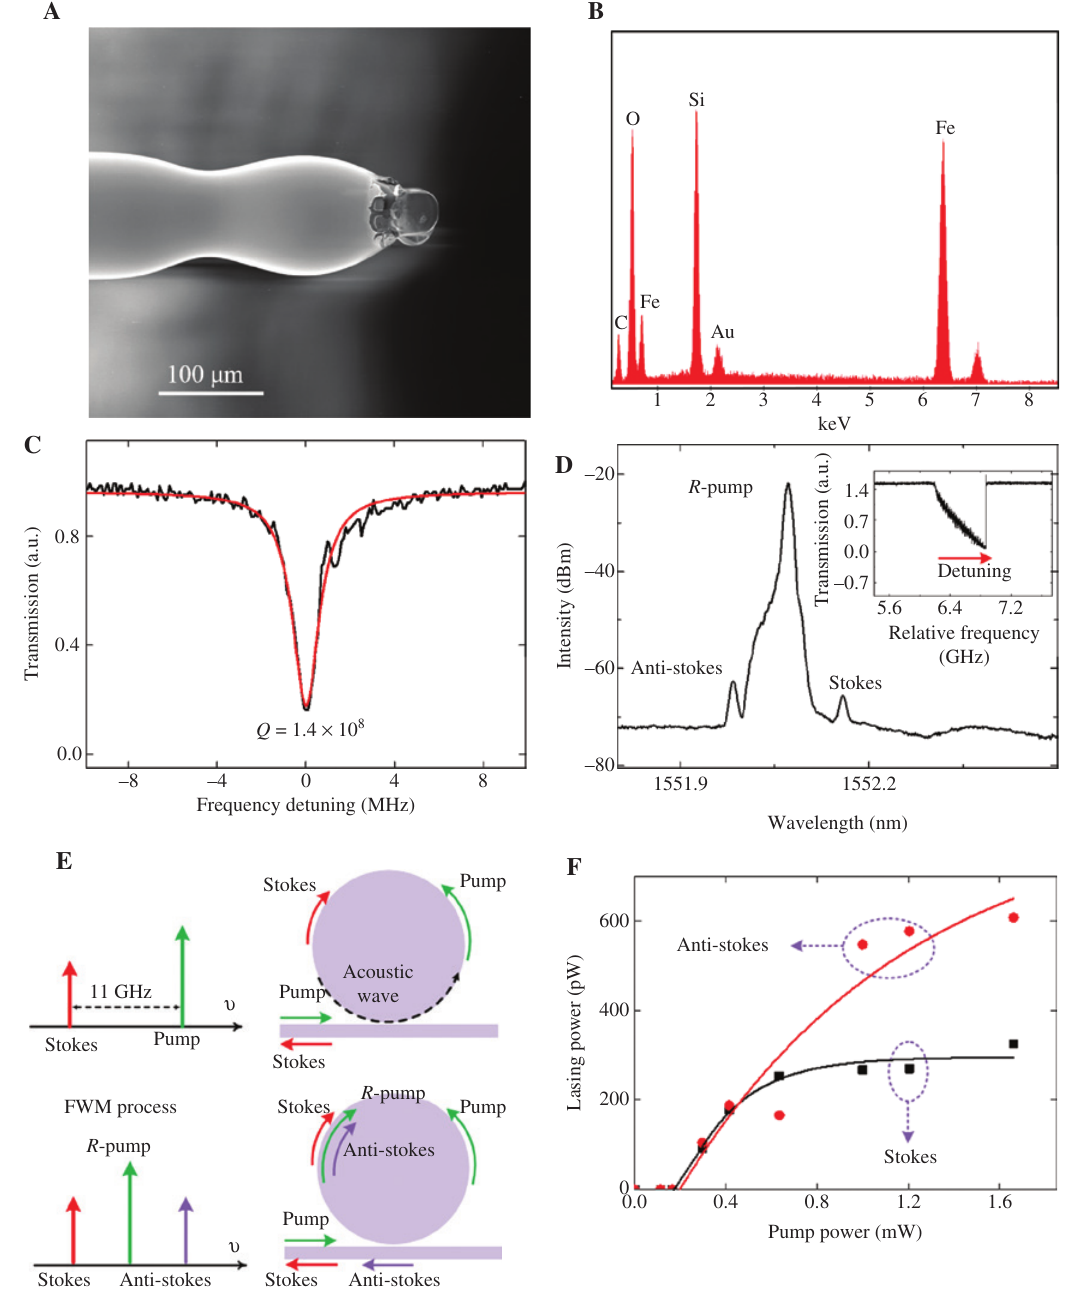
Figure 3: Device performance of the hybrid microbottle resonator with an equatorial diameter of about 114 μ m. (A) SEM image of the hybrid microbottle resonator. (B) Measured EDX spectroscopy of the coating area. (C) Measured transmission spectrum of a specific mode. The red line is Lorenz fitting. (D) Brillouin laser spectrum in the backward direction. The inset is the measured asymmetric transmission spectrum of the specific mode. (E) Generation principle of the Stokes and anti-Stokes light. (F) The first-order Stokes and anti-Stokes lasing powers versus the pump